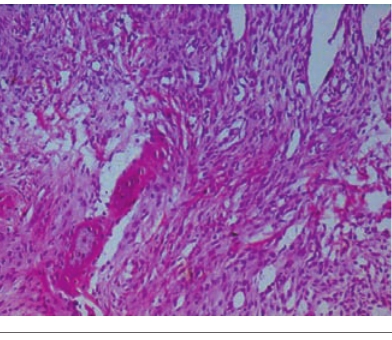
Figure 7. Photomicrograph showing fibro- cellular mesenchymal tissue and few mult- inucleated giant cells (Haematoxylin and Eosin, 200 ¥